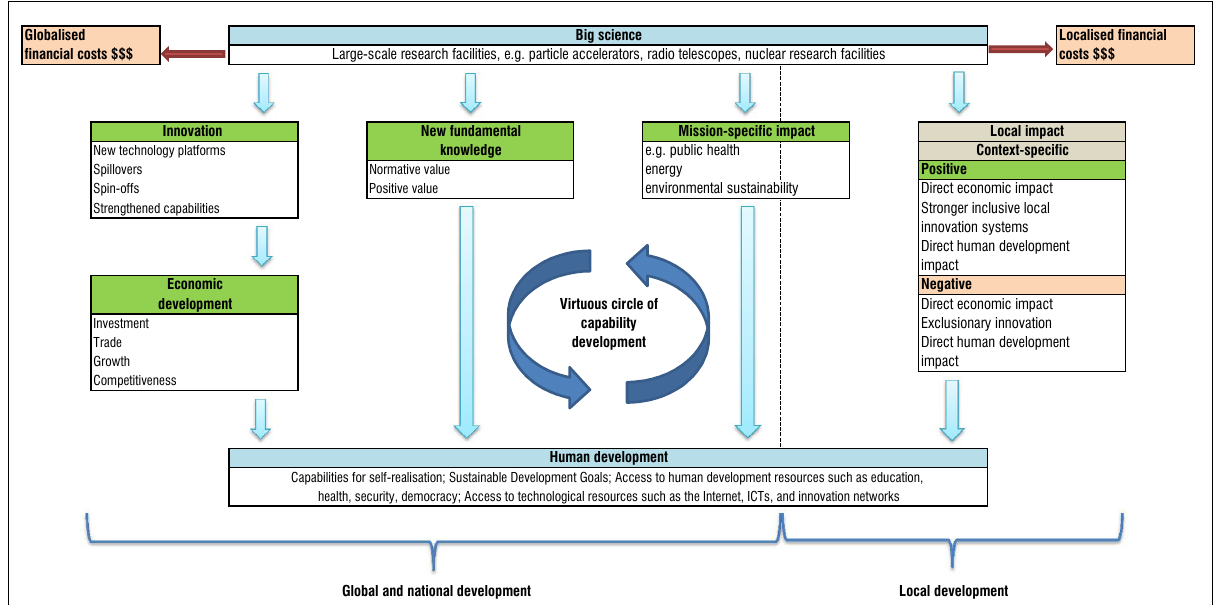
figure 1: Big science and human development relationship in